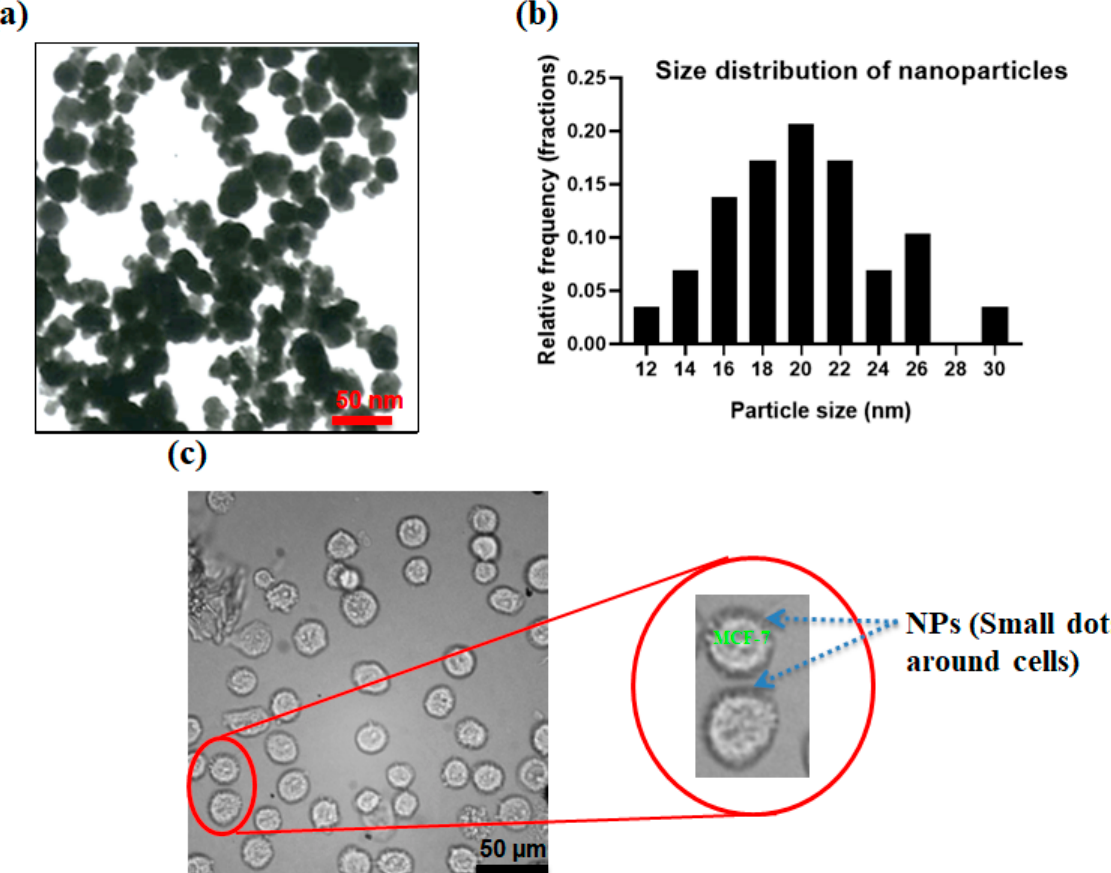
Figure 4. ( a ) Nanoparticles; ( b ) size distribution for NPs; ( c ) optical image of MCF-7 which are surrounded by antibody-conjugated nanoparticles .